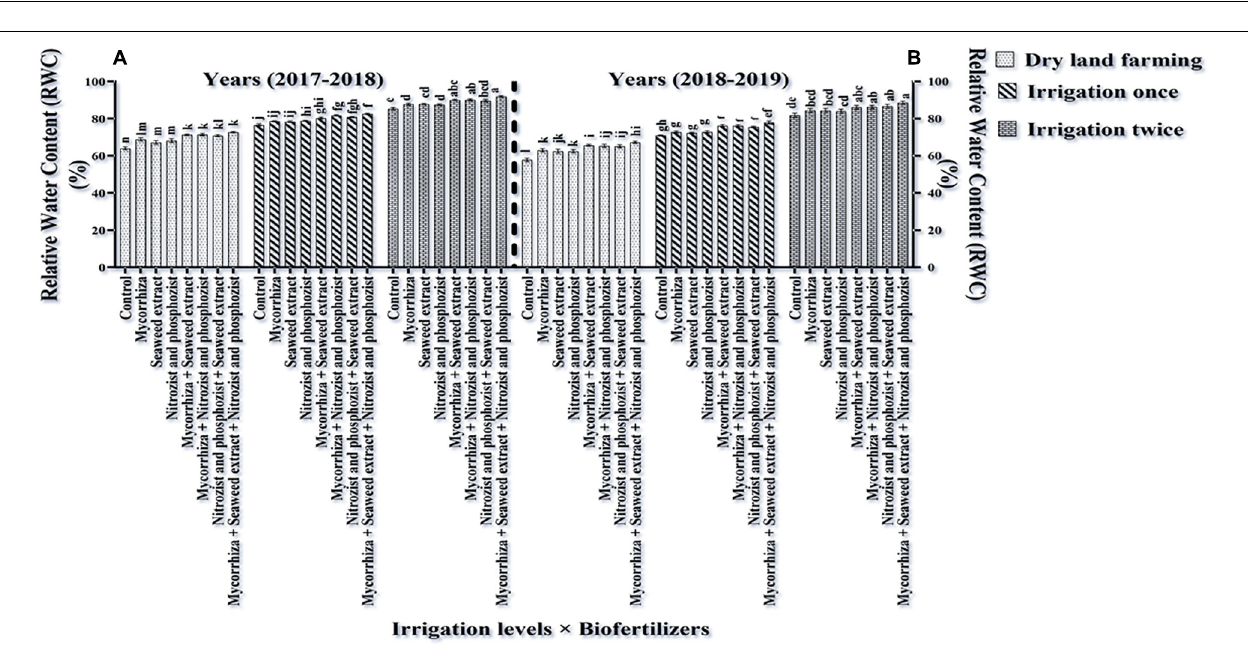
FIGURE 3 | Mean comparisons of the dual interaction effect of irrigation × biofertilizers on colonization percentage trait of wheat plant root in two seasons of experiment (2017–2018 and 2018–2019). Means in each column followed by similar letter(s) are not significantly different at 1% probability level by the LSD test.